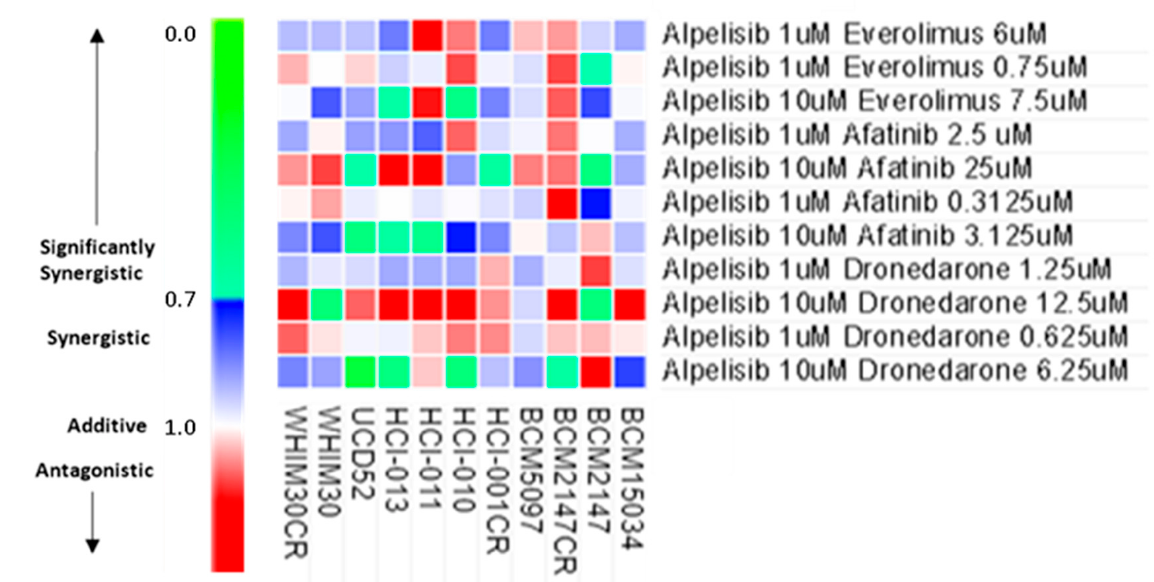
Figure 8. In vitro synergism screening revealed synergistic dose ratios across multiple PDX models. CDI for each drug combination at 4 dose ratios each, green denotes significant synergism, blue denotes synergism, and red denotes antagonistic effects, while white is additive.